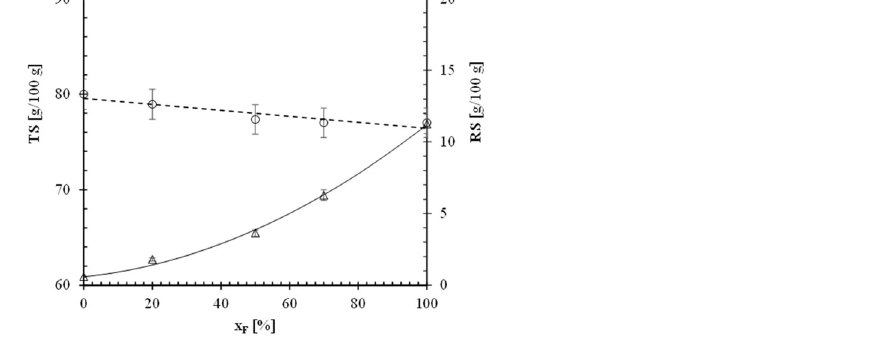
Figure 1. Effect of the percentage (x F ) of high-amylose wheat flour in the flour mixture used to prepare fresh pasta samples on the total starch (x TS : ) and resistant starch (x RS : (cid:52) ) weight fractions of the pasta. (cid:35)